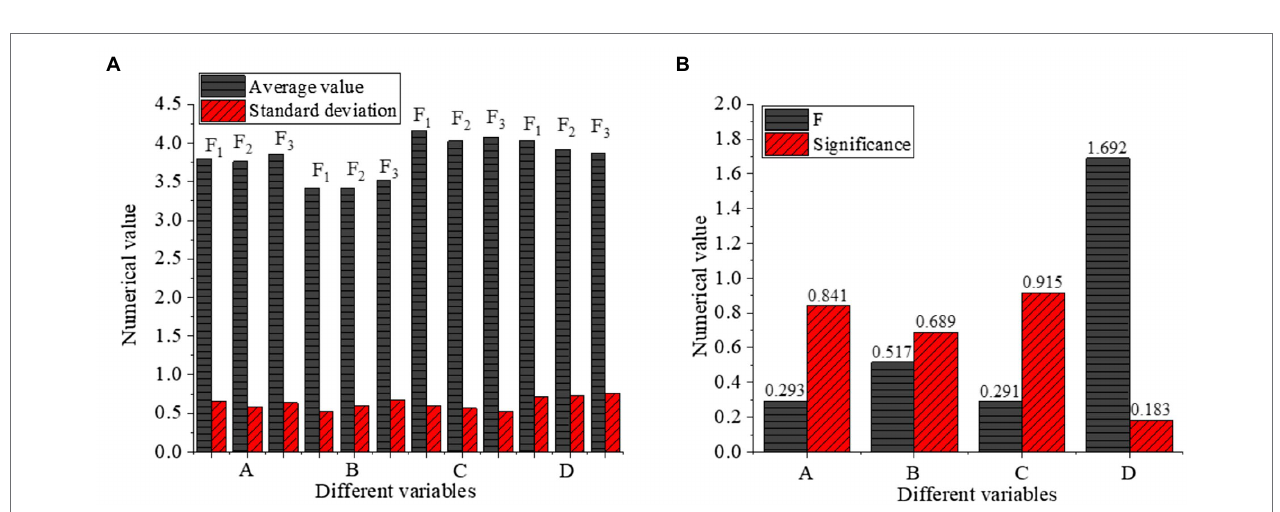
FIGURE 10 | The results of one-way ANOVA of enterprise nature ( A : different variables with Numerical value, B : different variables with Numerical value, F1: Sino-foreign joint venture, F2: Foreign enterprise, F3: Chinese enterprise, A: Cross-cultural competence, B: Cross-cultural adaptation, C: Entrepreneurial intention, D: Psychological adaptation of venture entrepreneurs).